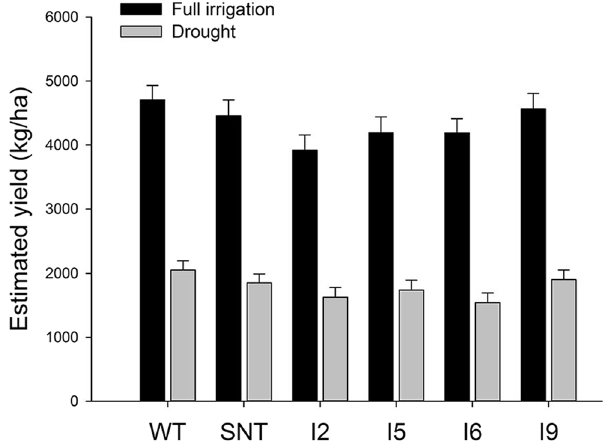
Figure 4. Seed cotton yield under full irrigation and water deficit conditions at Maricopa, Arizona in 2011. WT, wild-type cotton (Coker 312); SNT, segregated non-transgenic cotton; IPT2 to IPT9, four independent IPT - transgenic cotton lines.